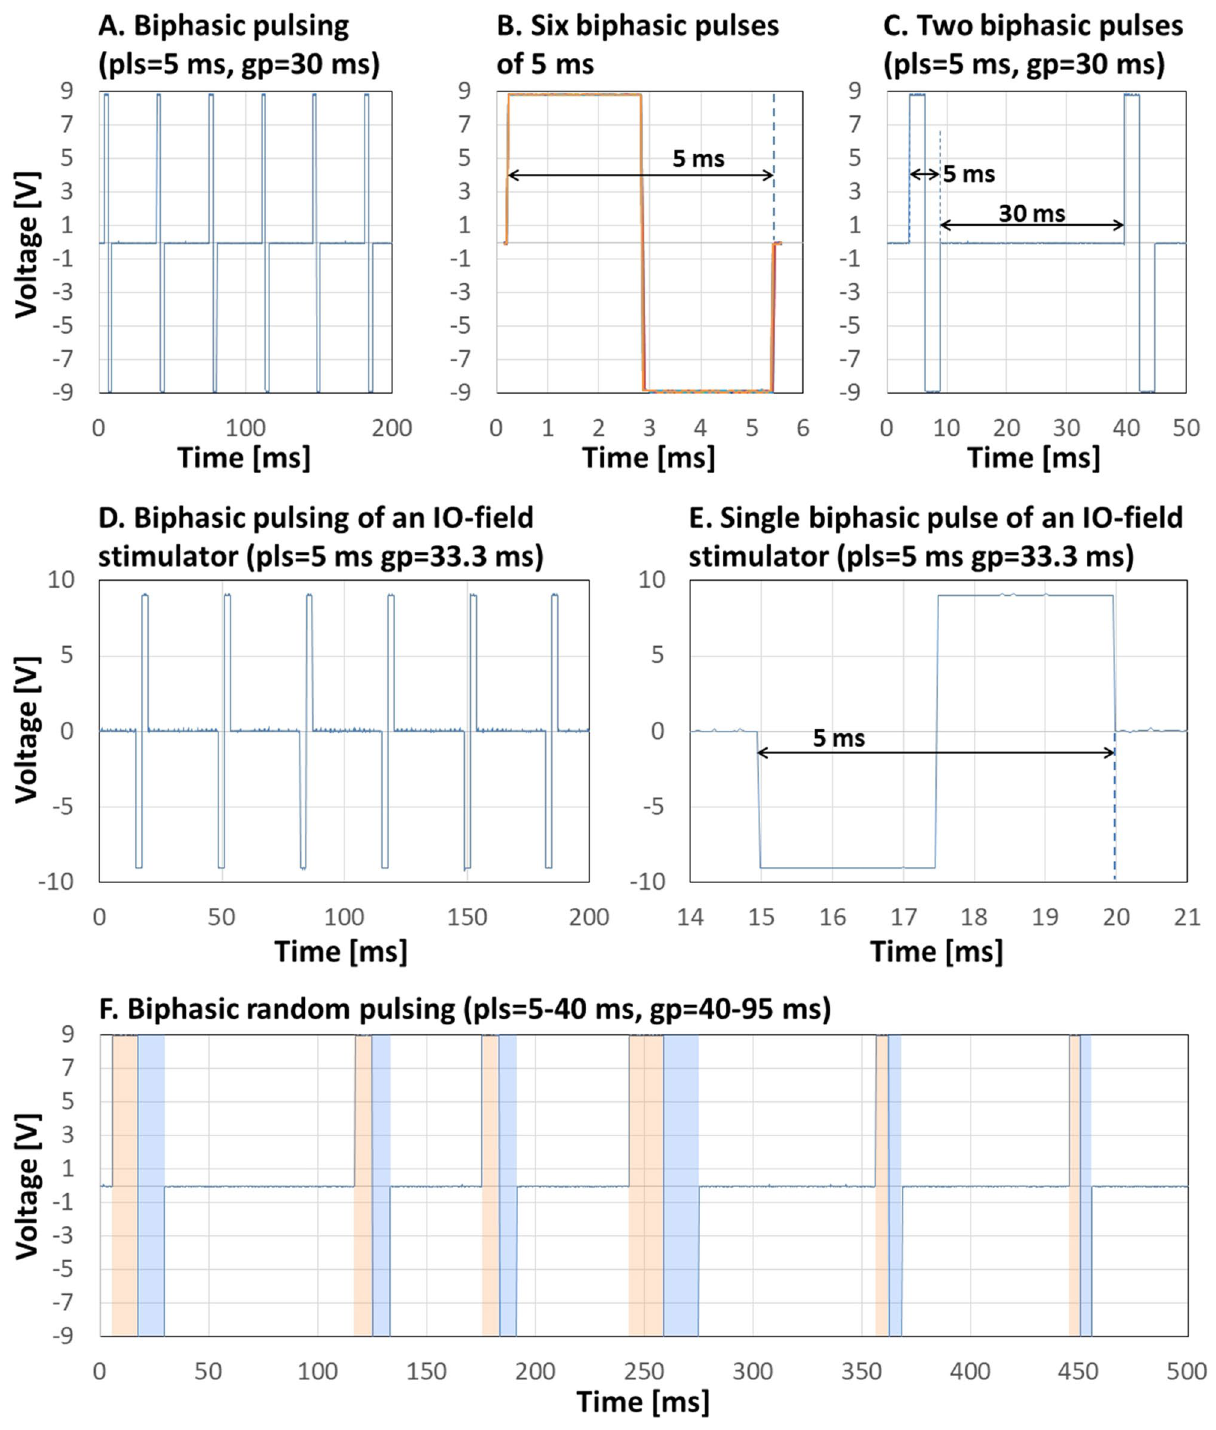
Figure 2. Biphasic pulses measured with an oscilloscope. ( A ) Depicts sequence of polyphasic pulses with a length of 5 ms (pls), followed by an unpulsed gap of 30 ms (gp). Depending on the polarity, the electric potential switches from + 9 to − 9 V. ( B ) Displays an overlay of the six pulses shown in ( A,C ) depicts the first two biphasic pulses shown in ( A ). ( D ) Shows a biphasic pulse sequence (5 ms pulses followed by a gap of 33.3 ms) from a commercial device (“MyoPacer” from IonOptix ), ( E ) a magnified representation of a single biphasic pulse (5 ms) of the mentioned device. ( F ) Depicts a sequence of biphasic random pulses, generated by MyoPulsers’ “Randomizer”-function. The single pulses range from 5 to 40 ms, followed by a unpusled gap ranging from 40 to 95 ms. For better visualization, the two phases of every pulse are indicated by different